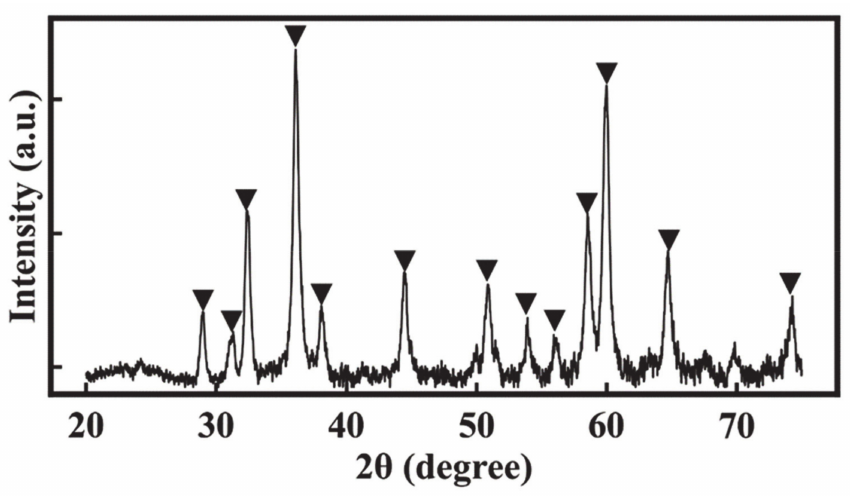
Figure 1. X-ray diffraction pattern of the as precipitated material ( (cid:72) —peaks corresponding to JCPDS file 24-0734 of Mn 3 O 4